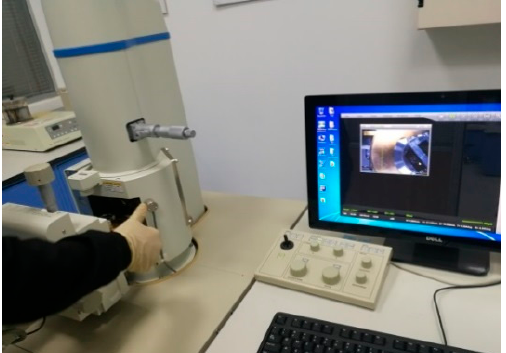
Figure 17. Scanning electron microscope test device.